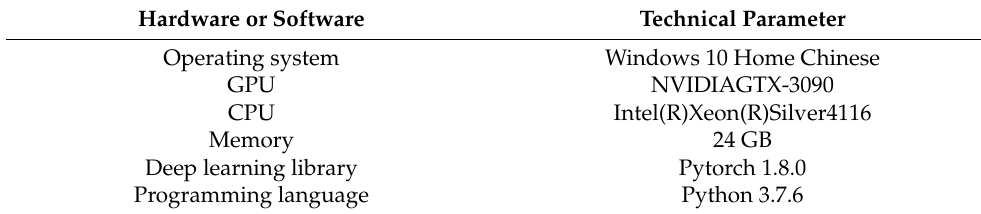
Table 1. Configuration of hardware and